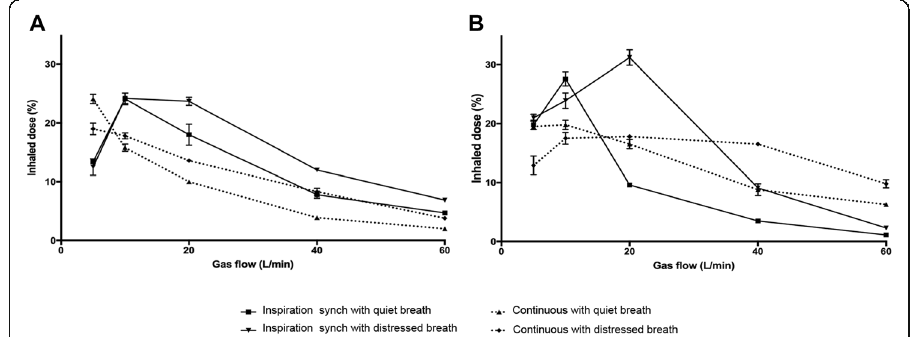
Fig. 2 Comparison of inhaled dose (%) between inspiration synchronized and continuous nebulizer placed at the inlet of humidifier ( a ) and close to patient ( b ). Inhaled dose of inspiration synchronized nebulizer peaked at gas flow of 10 L/min during quiet breathing and 20 L/min during distressed breathing, regardless of nebulizer placement. VMN, vibrating mesh